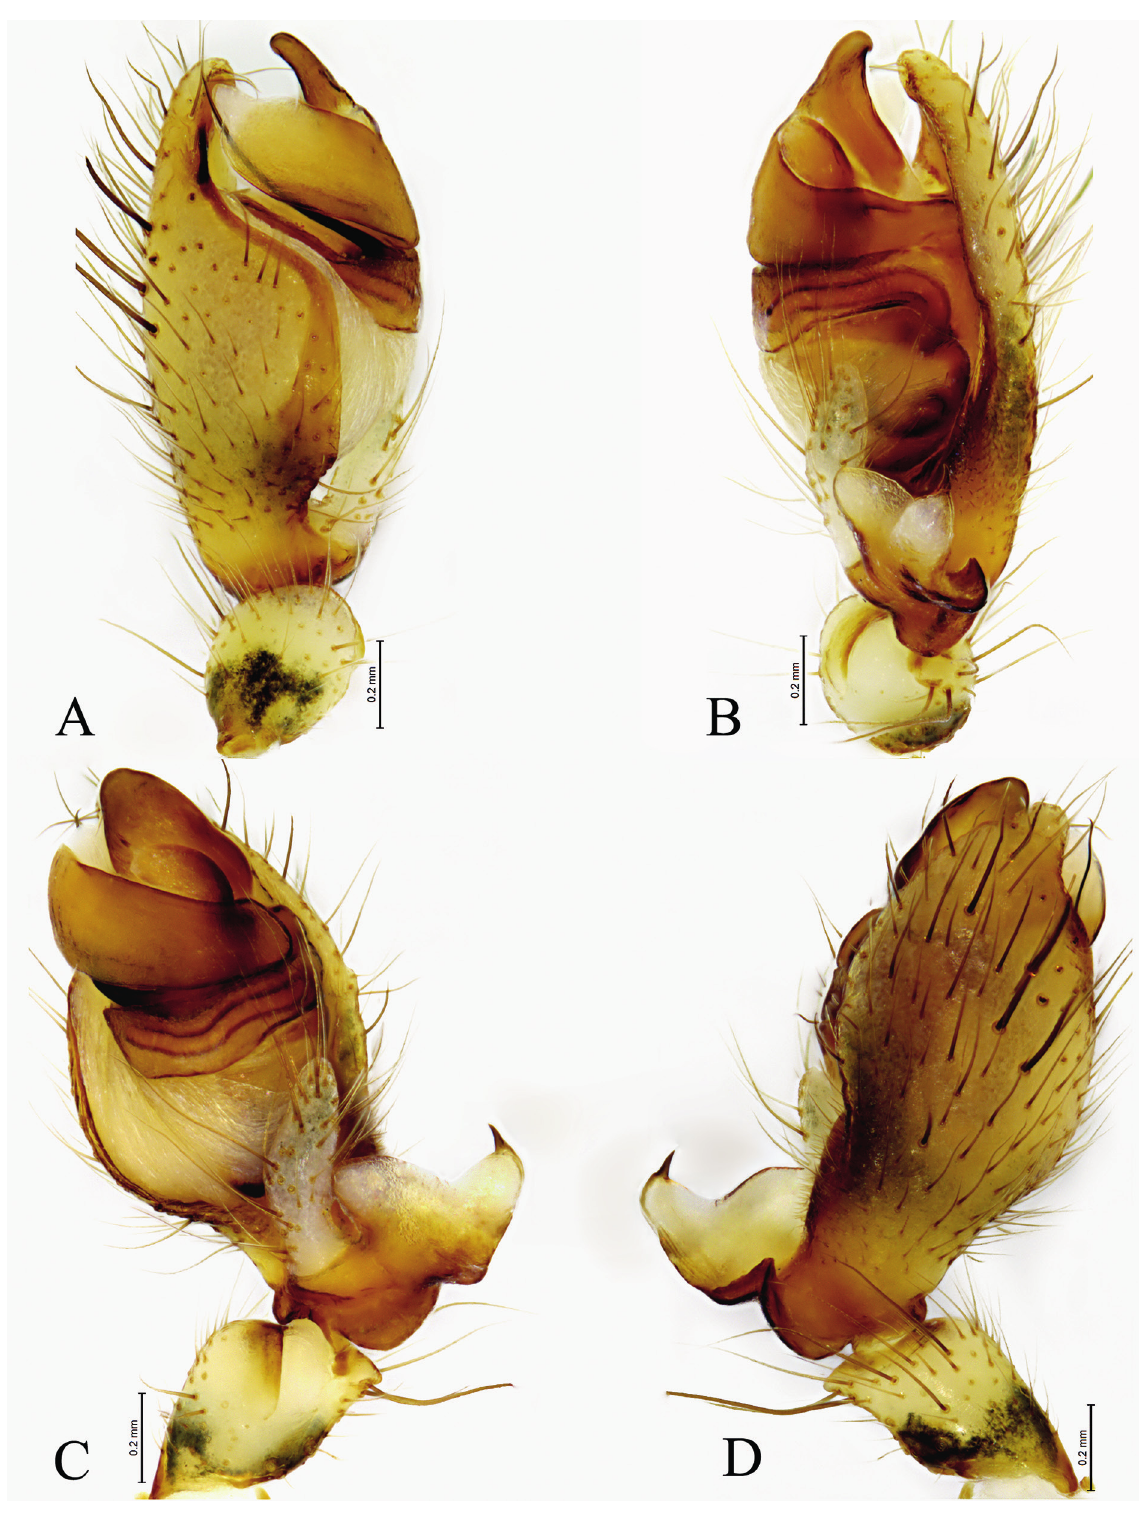
Fig. 20. Meta weining sp. nov., ♂, holotype (SWUC-T-TEg-08-01). A . Left palp, prolateral view. B . Same, ventral view. C . Same, retrolateral view. D . Same, dorsal